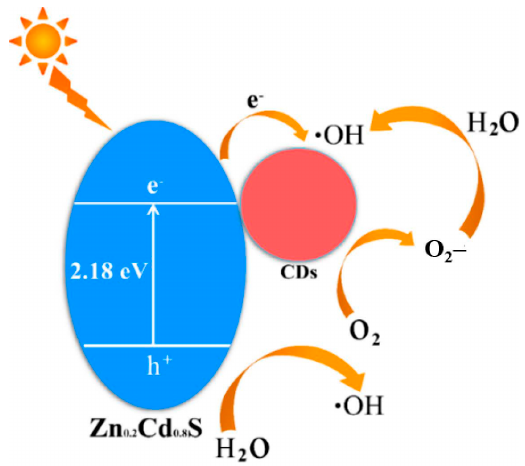
Figure 8. Schematic diagram of charge separation and transfer in Zn 0.2 Cd 0.8 S@CDs.